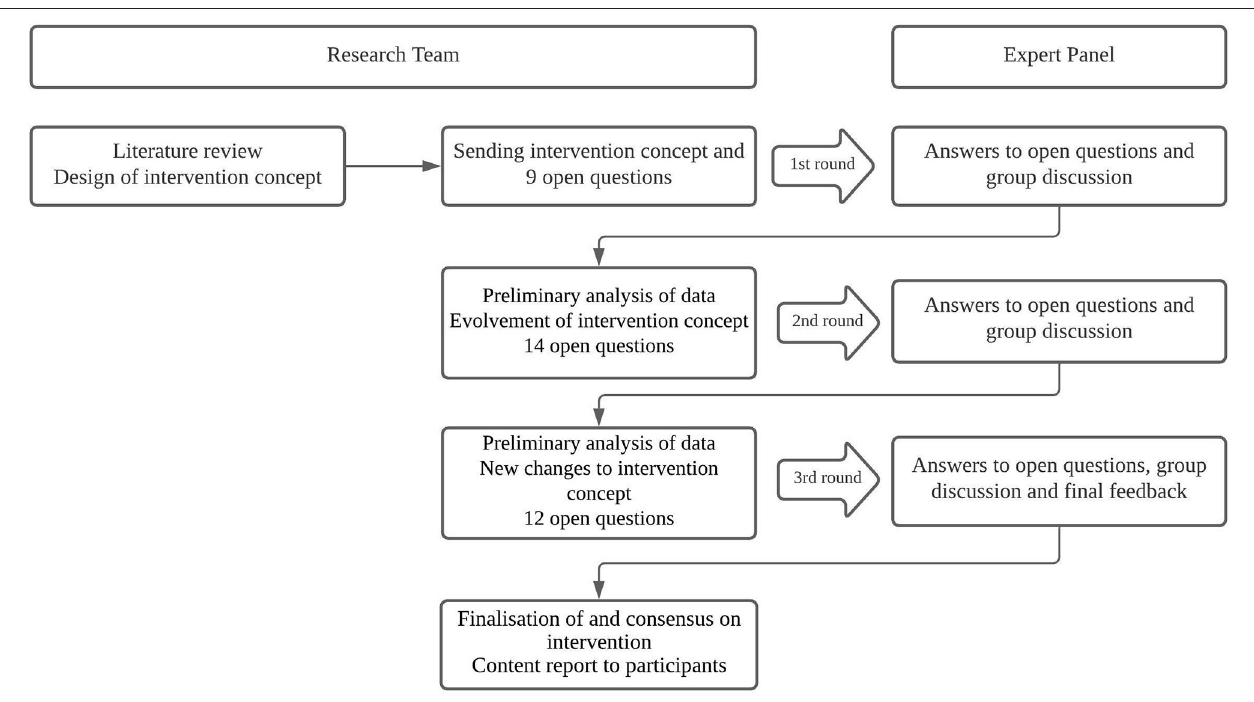
FIGURE 1 | Flowchart of the three-round Delphi procedure.